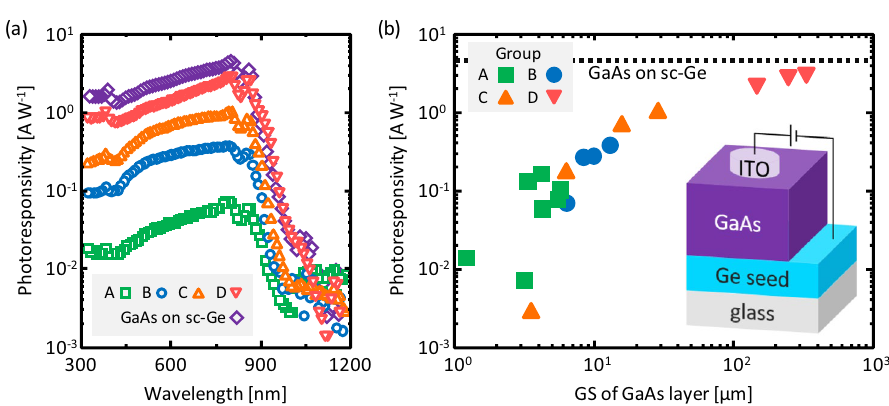
Figure 6. Photoresponse properties of samples in Groups A–D, where bias voltage was 0.3 V. ( a ) Photoresponsivity of samples in Group A ( T anneal = 375 °C), Group B ( T anneal = 375 °C), Group C ( C As = 1.2 × 10 20 cm −3 ), and Group D ( t AE = 10 min). ( b ) Maximum photoresponsivity values for each spectrum as a function of GS. Data for GaAs on sc-Ge(111) wafer shown for comparison. Inserted image shows schematic diagram of sample for